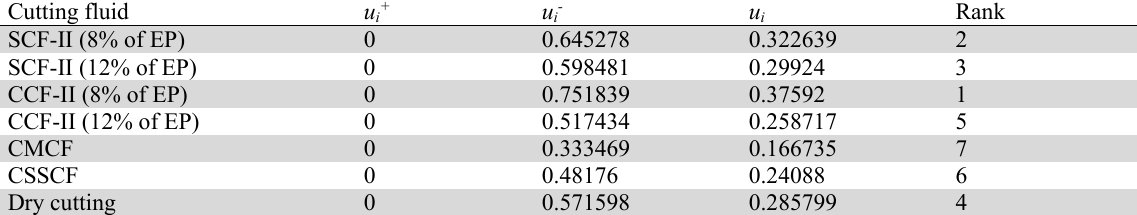
Computational details of the ROV method for case study 3 Cutting